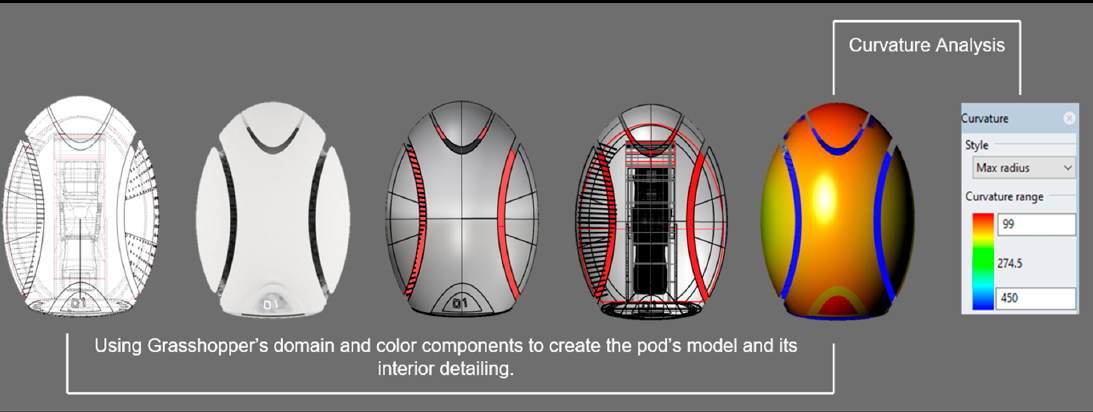
Figure 1. The “Reviving Pod” modeling design with technical, rendered, shaded, and X-ray view curvature analysis rendered in the Rhino program (computational modeling by the authors).